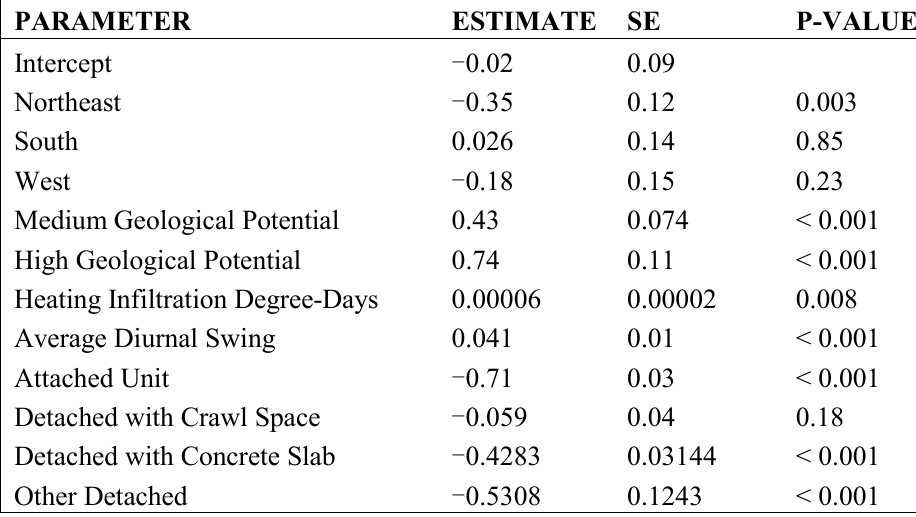
Table 2. Log-linear radon concentration model, fixed